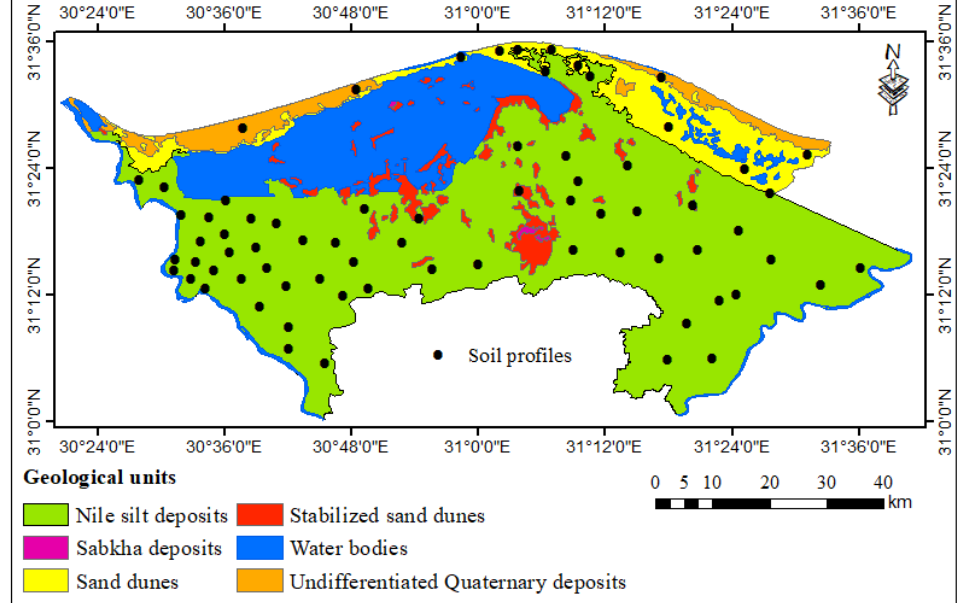
Figure 2. Geological map and soil profile locations .